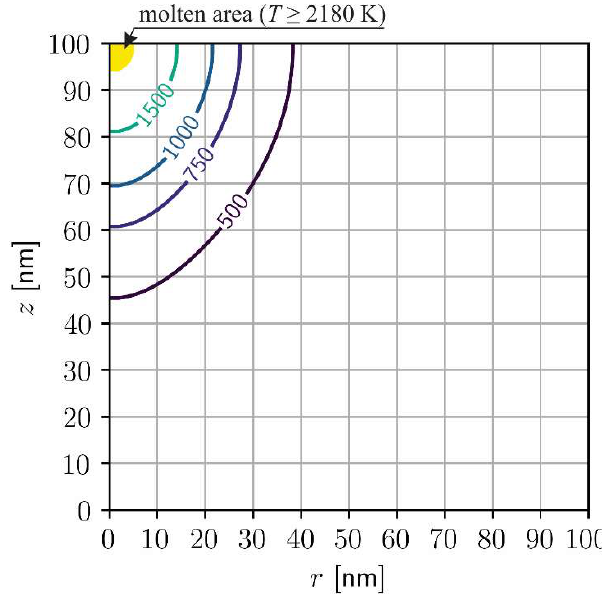
Figure 6. Temperature distribution after 25 ps, melting at the constant temperature, chromium, I 0 = 1.6 × 10 4 J/m 2 , t p = 10 ps.